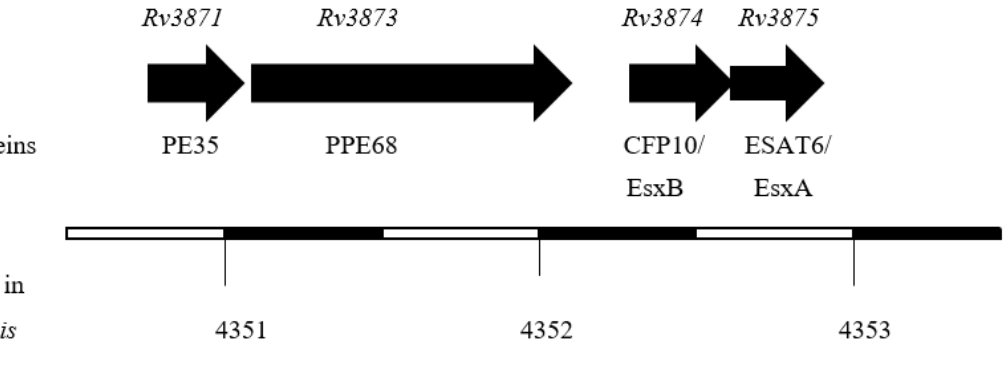
Figure 1. The organization of the CFP10 and ESAT6 genes in M. tuberculosis genome.